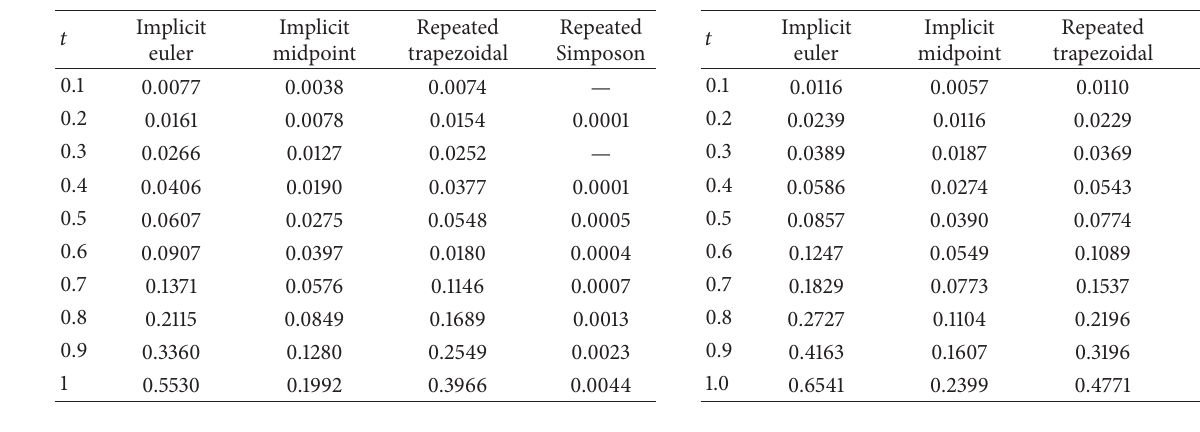
Table 3: Absolute errors in the solution of (58) when ℎ = 0.01 .